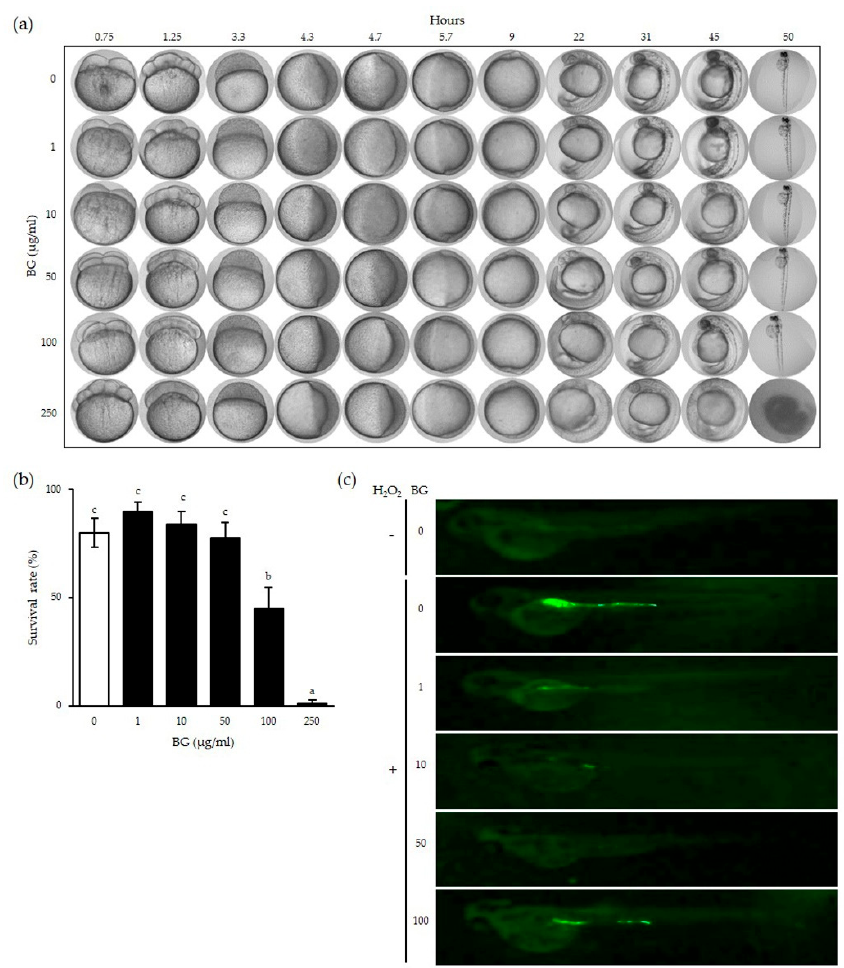
Figure 4. Cytotoxic and inhibitory effects of BG on ROS production in zebrafish embryos. Zebrafish eggs were incubated with BG in egg water for the indicated time ( a ). The survival rates of zebrafish eggs were determined by counting the hatched eggs ( b ). Zebrafish embryos were pretreated with the indicated concentration of BG for 24 h followed by additional 1 h H 2 O 2 stimulation and the pictures were taken ( c ). Data are shown as the means ± SD of three independent experiments. Significant differences between different concentrations were analyzed using Duncan’s multiple range test with one-way ANOVA, and values labeled with different letters were significantly different ( p < 0.05). White bar represents negative control. BG, black ginseng.